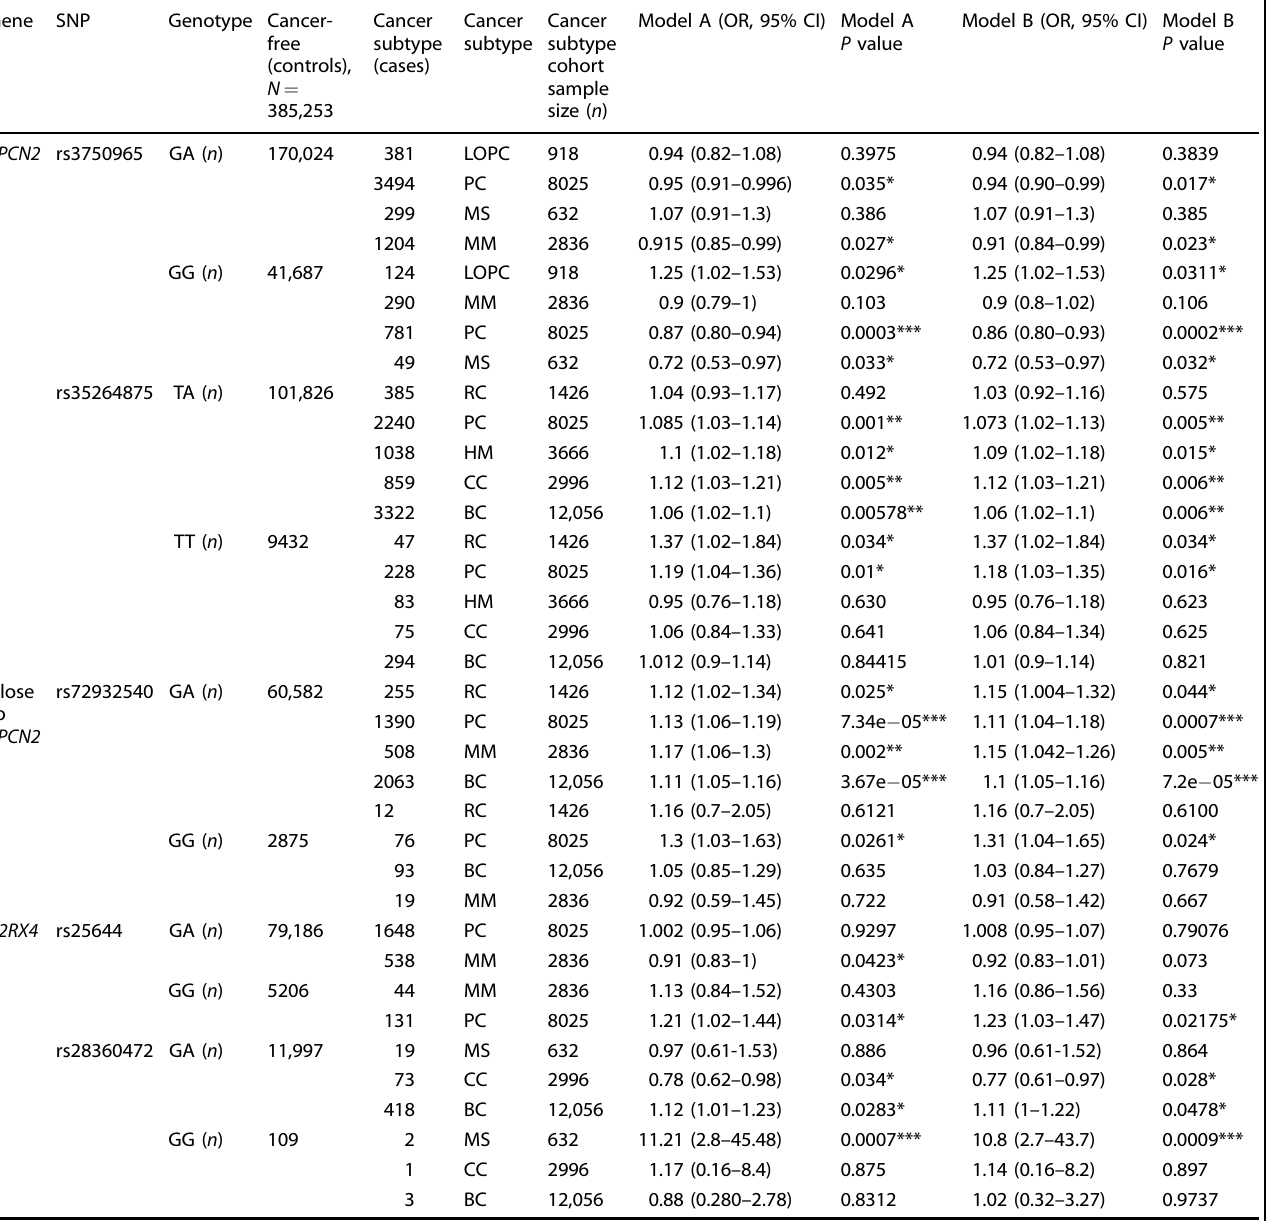
Table 4. Univariate and multivariate logistic regression analyses of genetic variants in TPCN2 and P2RX4 that signi fi cantly associated with the risk of various types of cancer at a local